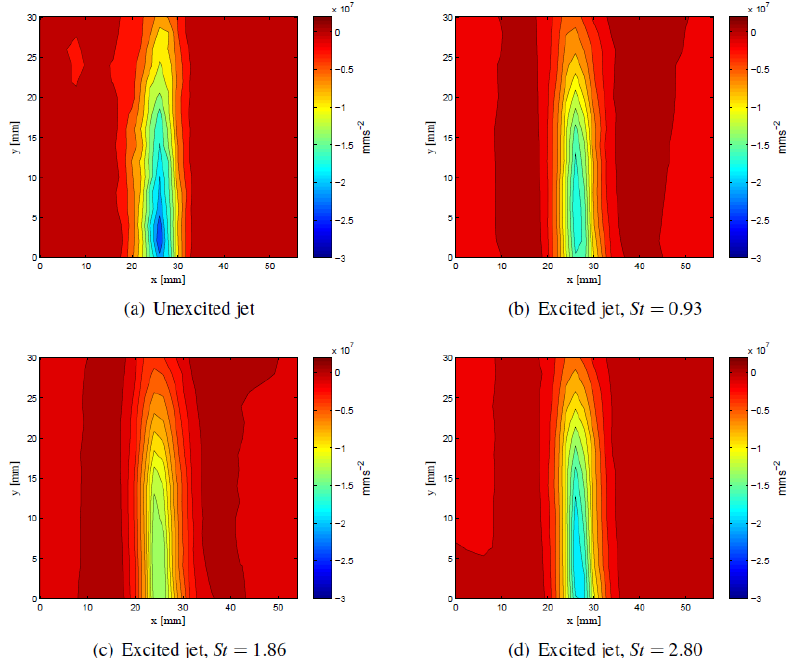
Figure 6. Average helicity density, h , on the z = 0mm plane: (a) for an unexcited jet; (b) for an excited jet with St = 0.93; (c) for an excited jet with St = 1.86; and (d) for an excited jet with St =